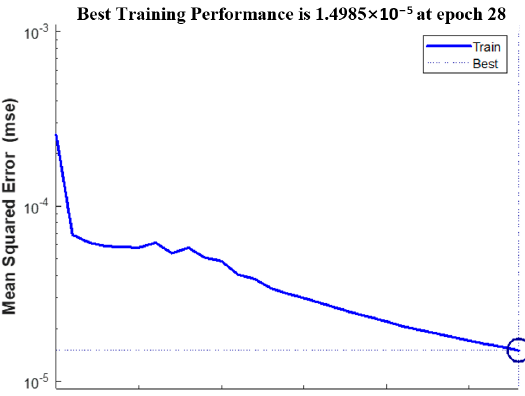
Figure 12. The error of CCT prediction during the training process using the neural network algorithm.